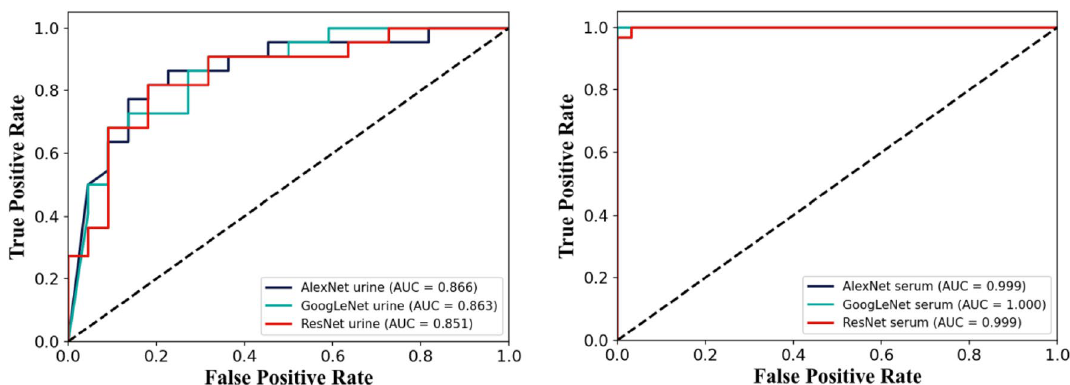
Figure 4. The ROC curves of AlexNet, GoogleNet and ResNet for urine samples on the left, and the ROC curves of AlexNet, GoogleNet and ResNet for serum samples on the right.